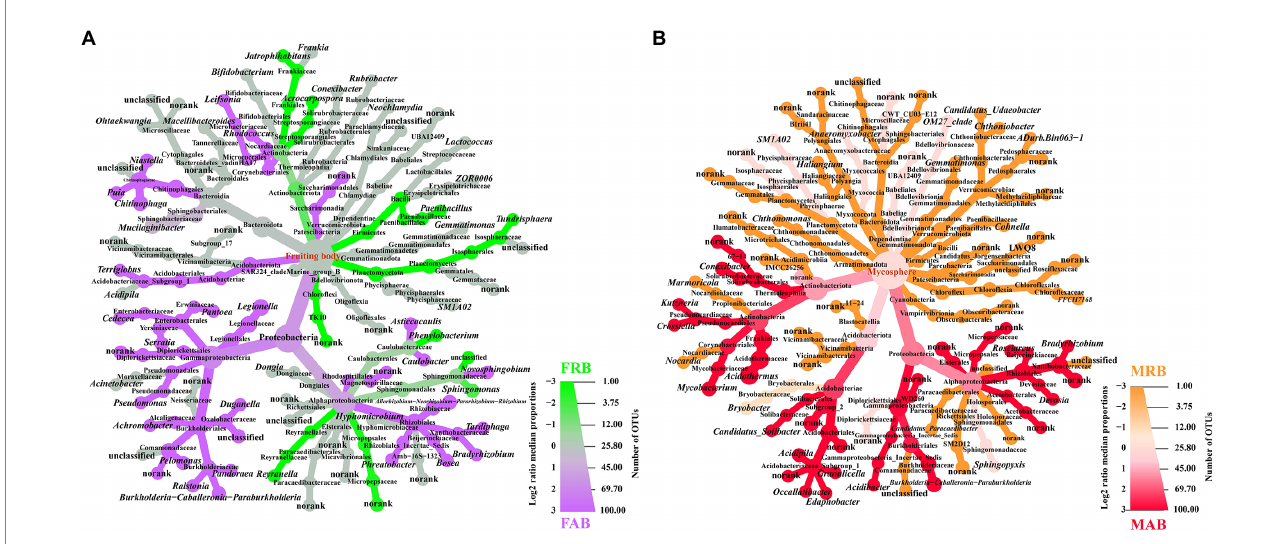
FIGURE 3 Heat tree of community classification and composition of the fruiting bodies and mycosphere. (A) Top 50 OTUs of abundant and rare bacteria of the fruiting body. (B) Top 50 OTUs of abundant and rare bacteria of the mycosphere. The size of the node is proportional to the number of OTUs within each taxon. Each figure shows the specific name of each classification level; the color scale and ruler on the right represent the log2 value of the median proportion and the number of OTUs, respectively; the colored picture shows the significantly different species compared between the two groups. Only the significantly different species will be colored, where purple represents the abundant bacteria of the fruiting body, green represents the rare bacteria of the fruiting body, red represents the abundant bacteria of the mycosphere, and orange represents the rare bacteria of the mycosphere. FAB, abundant bacteria of the fruiting body; FRB, rare bacteria of the fruiting body; MAB, abundant bacteria of the mycosphere; MRB, rare bacteria of the